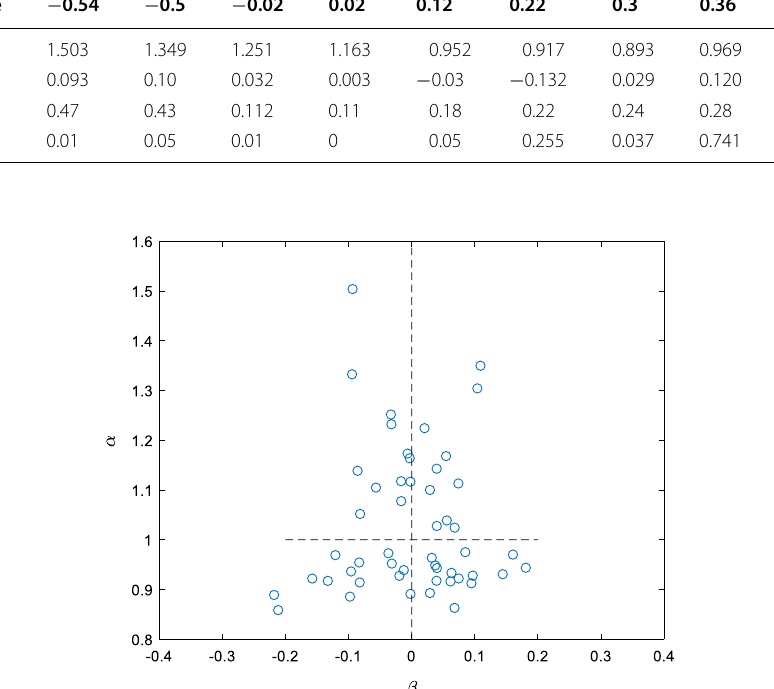
Table 1 Characteristic exponents of the redistributed signal with different transform p values P value 0.54 −